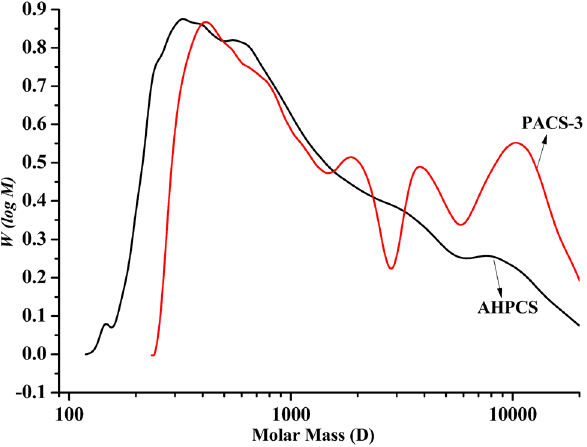
Figure 1: GPC curves of parent AHPCS and PACS - 3.